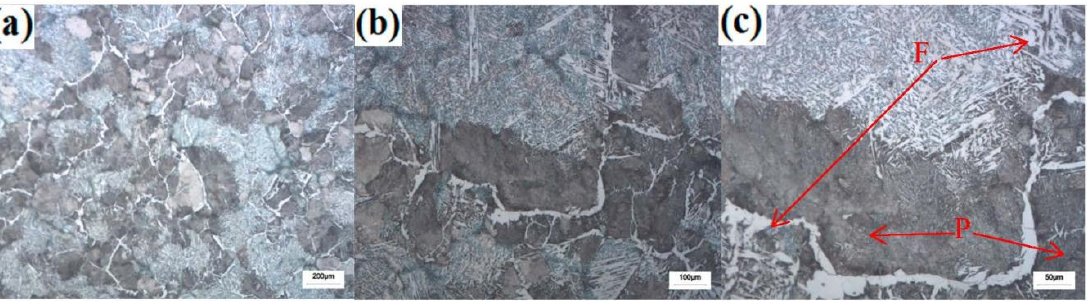
Figure 9. SEM and EDS morphology of typical CeAlO 3 -Ce 2 O 2 S-TiO inclusions in 2# sample.